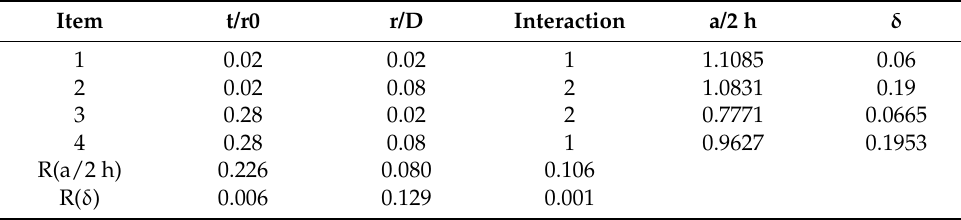
Table 6. Orthogonal tests for studying the interaction between t/r0 and